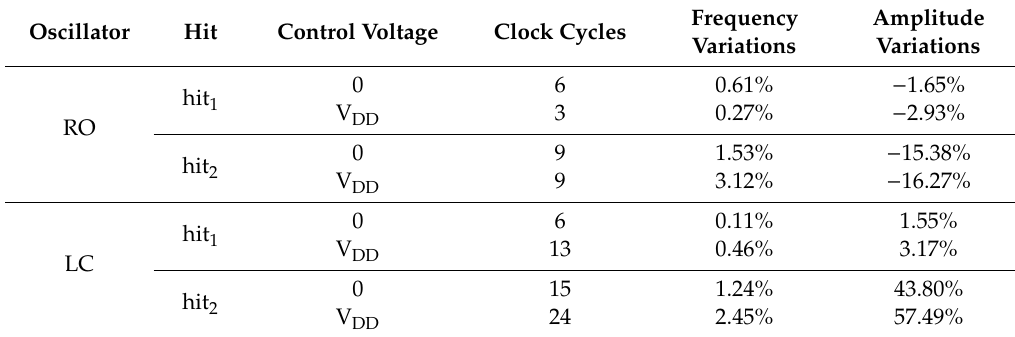
Table 2. Variations due to a SEE for RO-VCO and